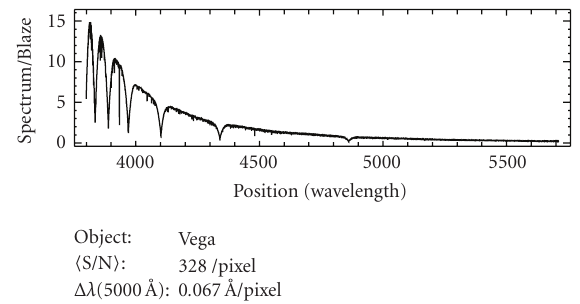
Figure 8: A sample result: Vega spectrum relative to the flat field spectrum and normalised to Figure 9.